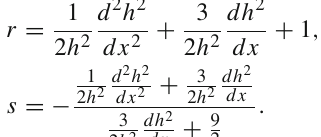
verse in the future. The evolution of the densities of matter and dark energy are comparable with each other for the high redshift values even though the matter density is dominating in the early universe and is diminishing in the late phase of the universe, that solves the coincidence problem as the acceler- ation began at low redshifts and this is well demonstrated in the Fig. 5. The current value of the matter density parameter estimated using the observational constraints is slightly lower than the observational value Ω mo = 0 . 3147 ± 0 . 0074 from Planck data [122] and the derived value Ω mo = 0 . 29 ± 0 . 07 from WMAP results [128]. Our estimation of the current val- ues of the matter density parameter are similar to the current value obtained for past THDE models [105,116] and slightly higher than the value for the THDE model with future event horizon as IR cutoff